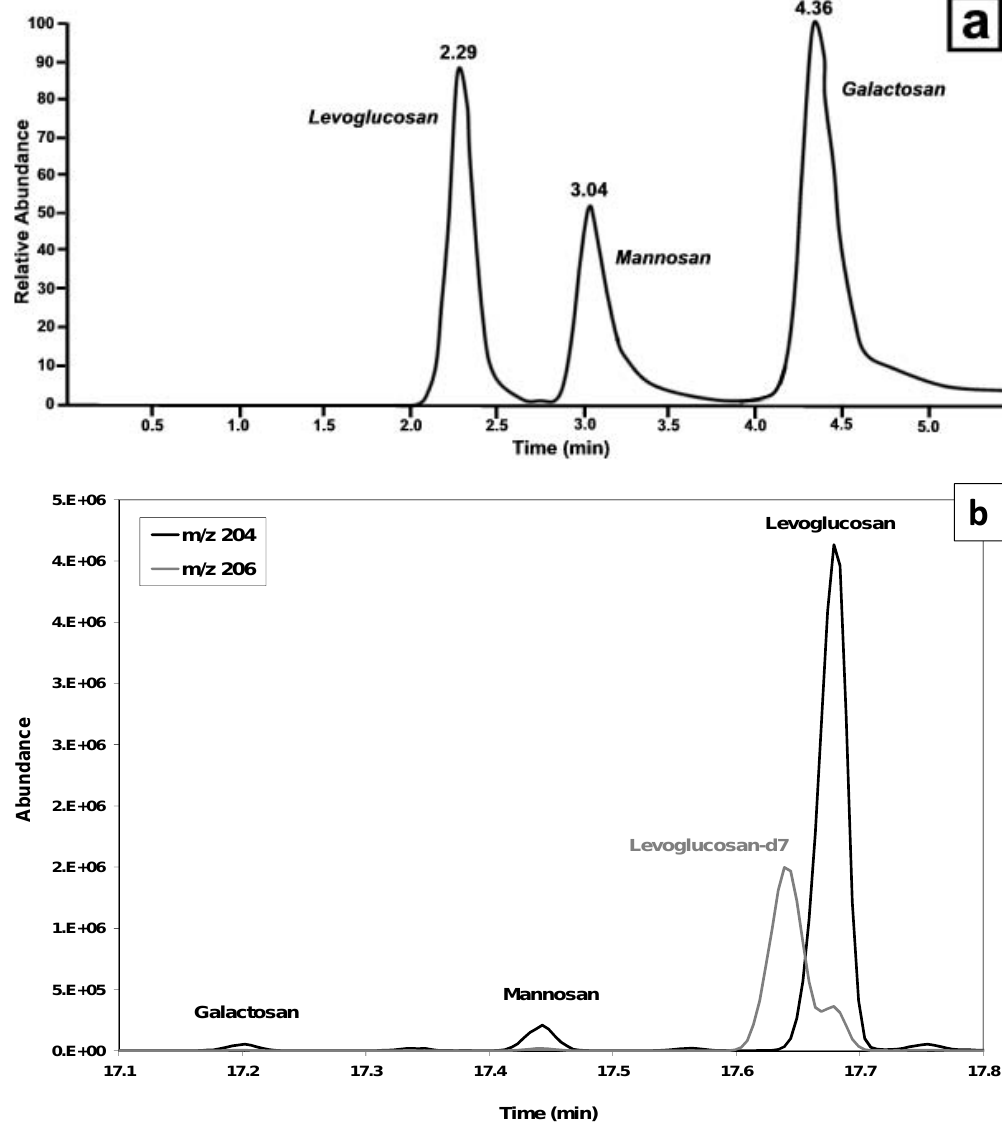
Fig. 1. LC-MS chromatogram (a) and GC-MS chromatogram on selective m/z (b)